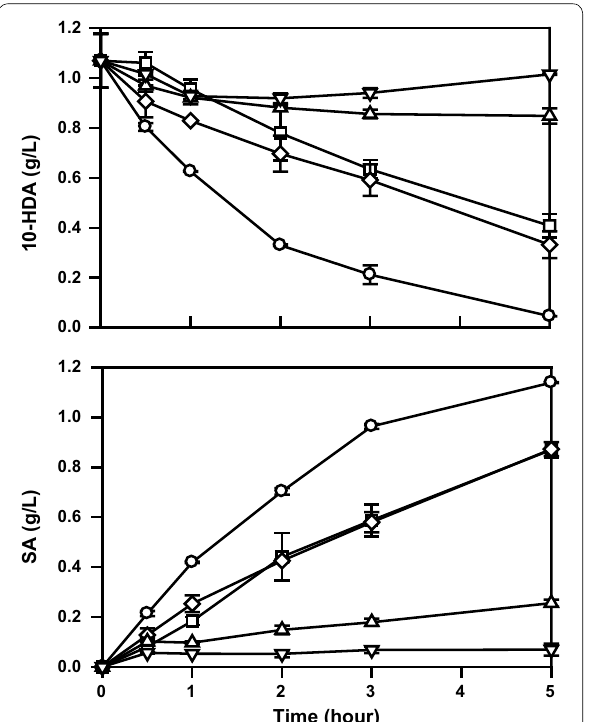
Fig. 2 Effects of decanoic acid concentration on the production of sebacic acid from 10-hydroxydecanoic acid. Error bars represent standard deviation of two independent runs. Substrates: